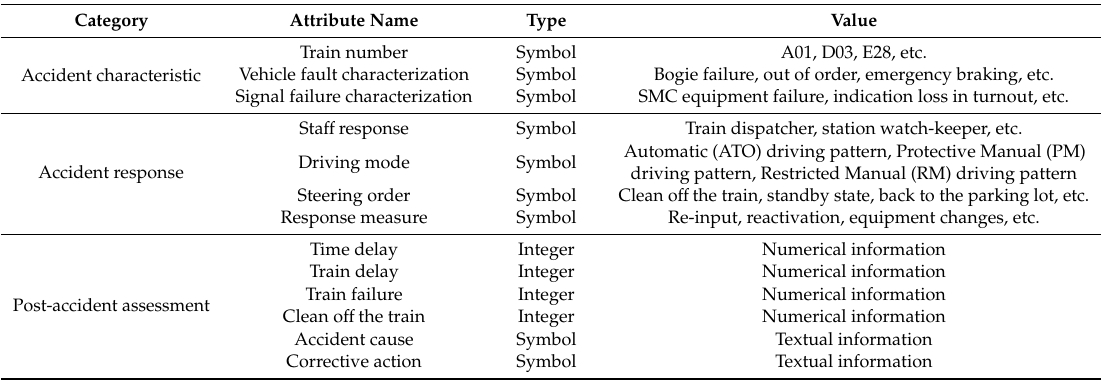
Table 3. Attributes of signal system failure